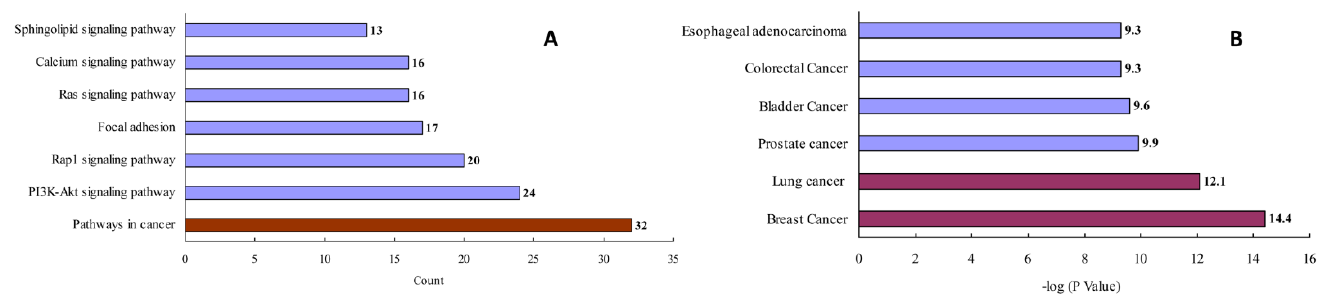
Figure 3. KEGG pathway ( A ) and GAD disease ( B ) enrichment analysis for the analyzed natural products.